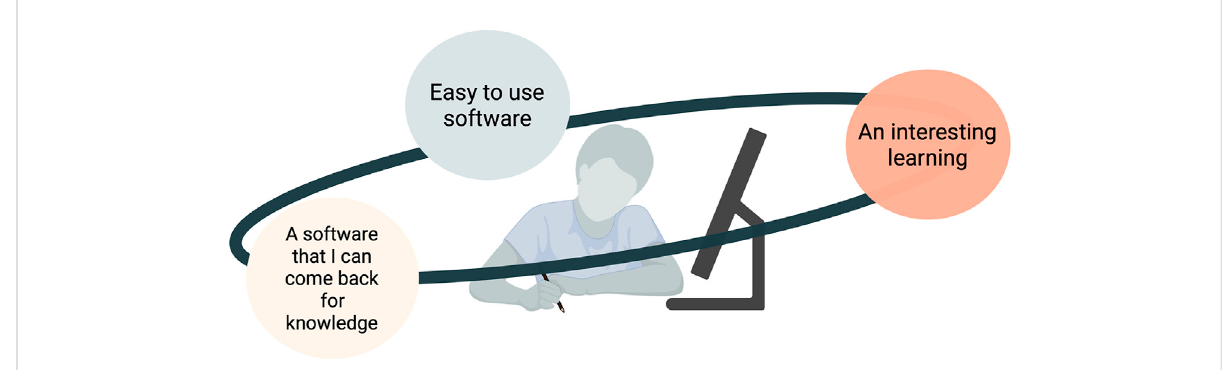
FIGURE 1 The student as the focus of the VL and inquiring about the learning goals ’ suitability, the software ’ s features and user-friendliness in the